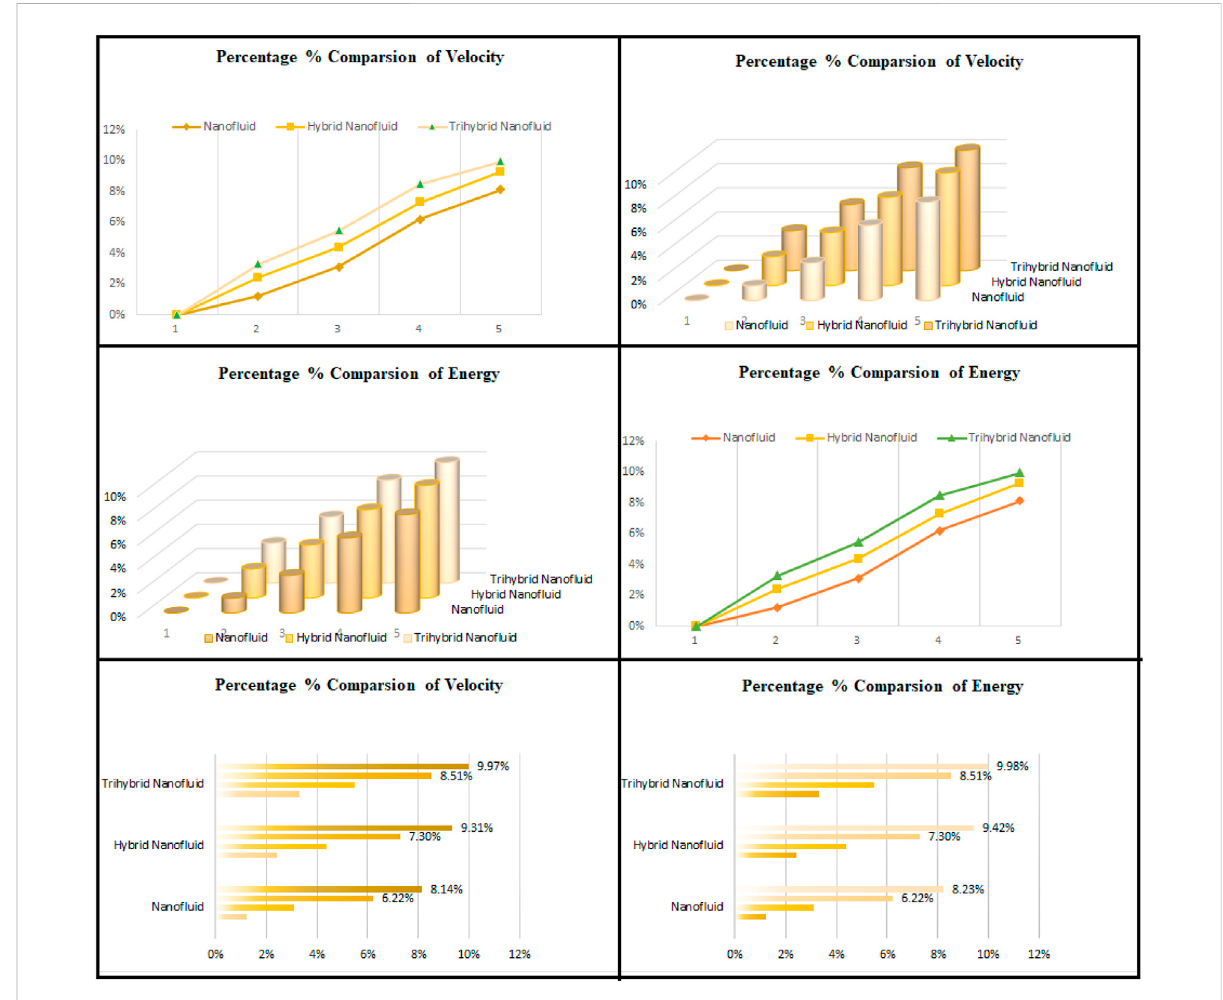
FIGURE 11 Percentage- and column-wise comparison of nano fl